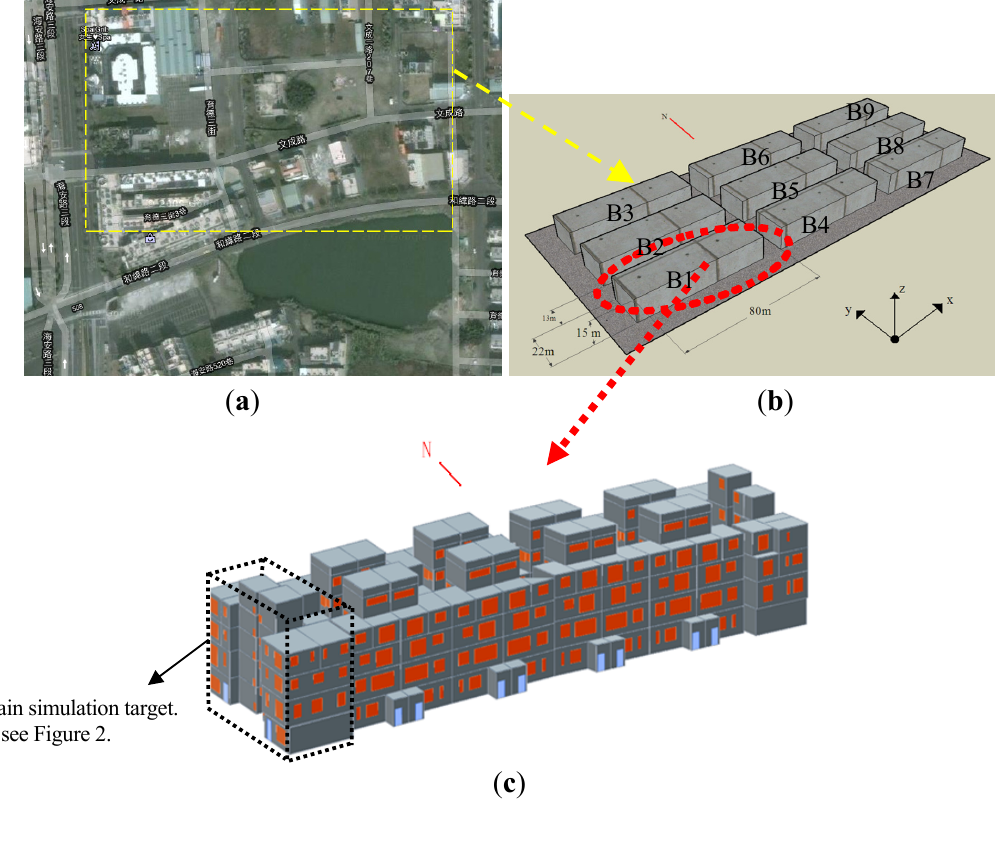
Figure 1. Objective of this study. ( a ) Study area (yellow dotted region); ( b ) Modified study area; ( c ) A city block is composed of 20 attached RC